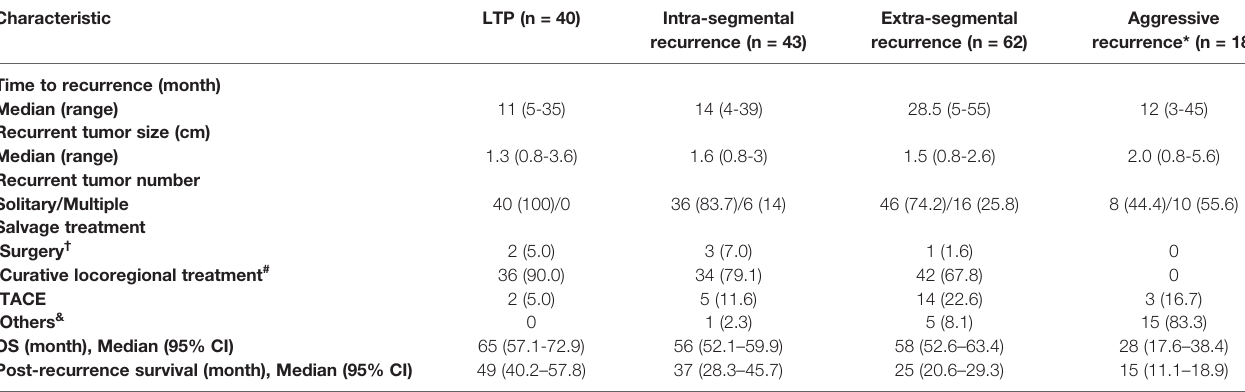
TABLE 3 | Characteristics, salvage treatments, and outcomes for different recurrence patterns. Characteristic LTP (n =